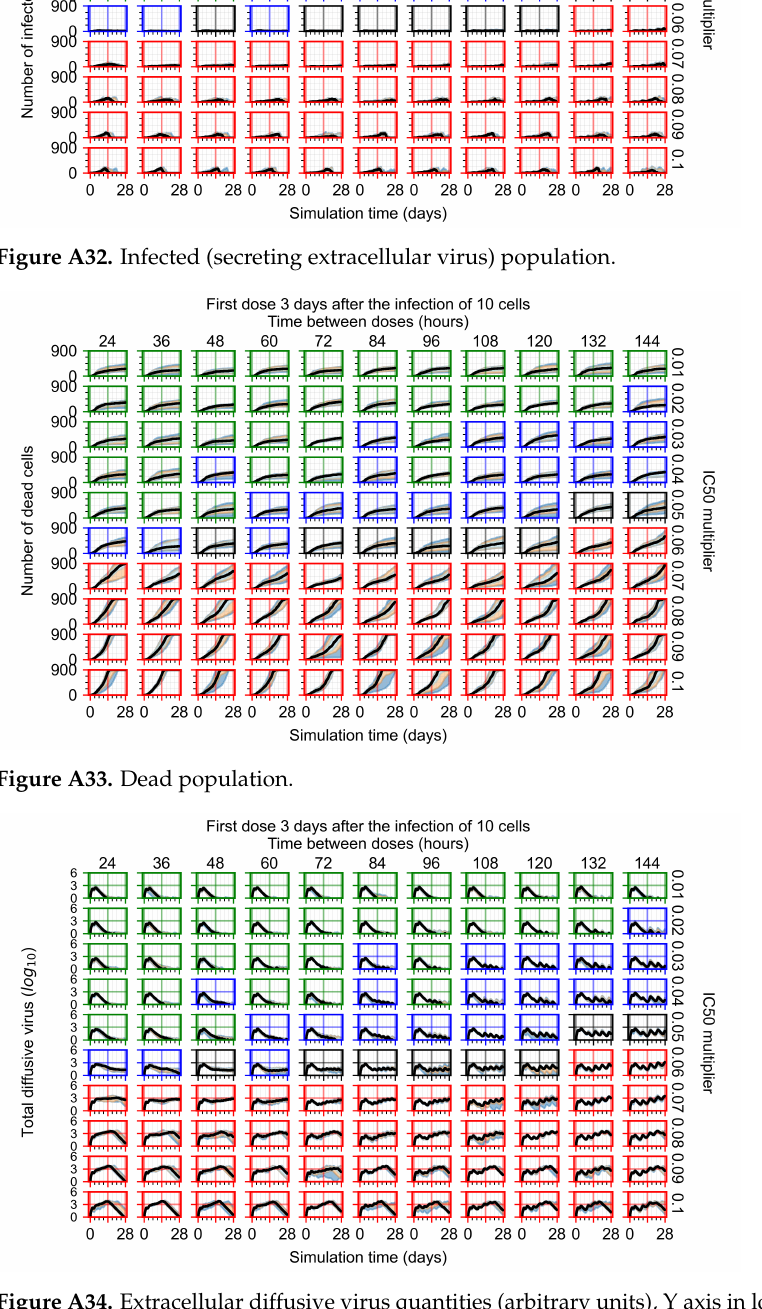
Figure A34. Extracellular diffusive virus quantities (arbitrary units), Y axis in log scale, and exponent values as tick